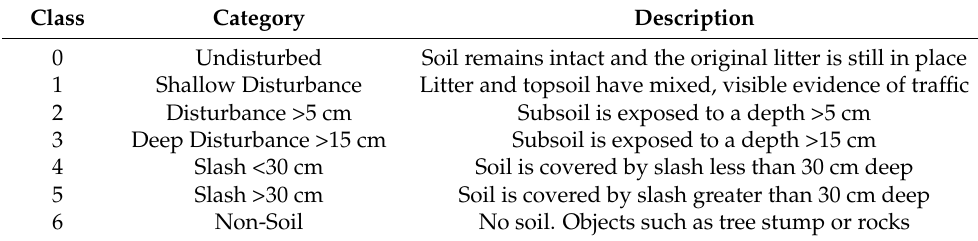
Figure 2. A map of the study site showing the positions of the landing (green square marked 148) of the skidding trails (continuous thick lines in blue and red) and of the soil survey transects (legend). Table 1. Soil survey classification.